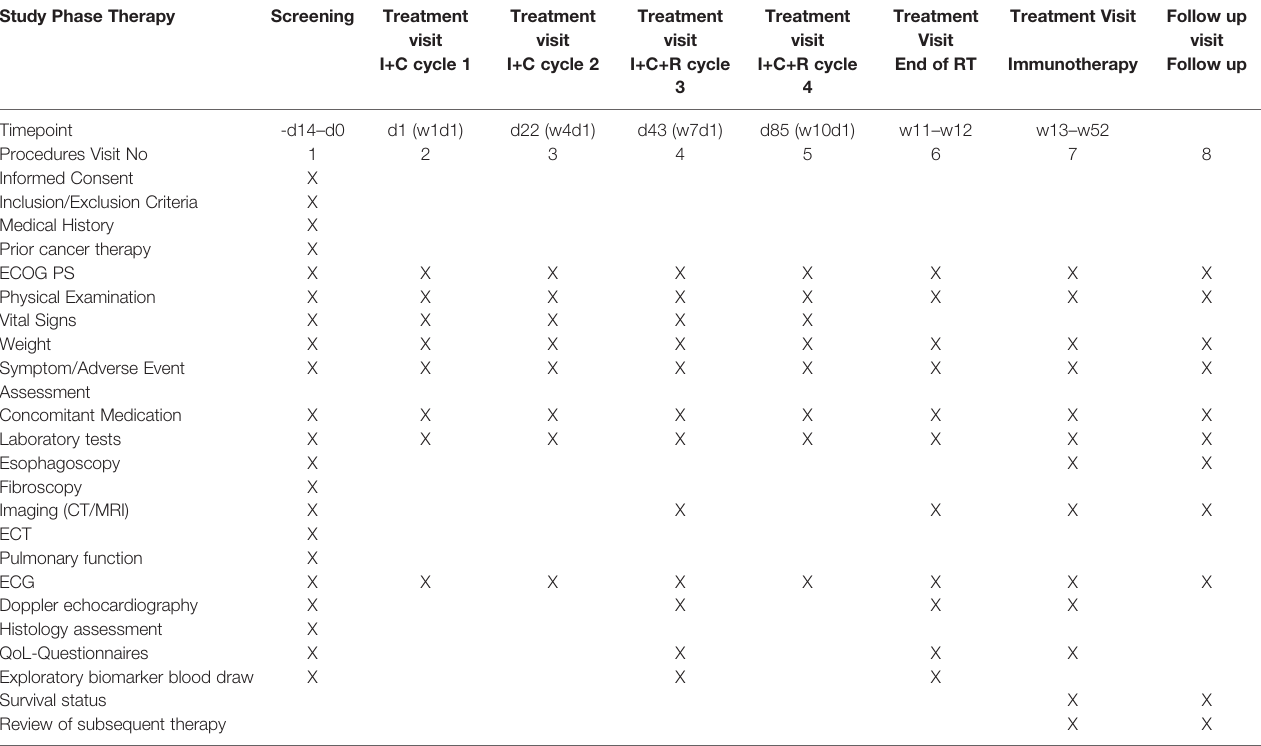
TABLE 2 | Flowchart of enrollment, interventions, and